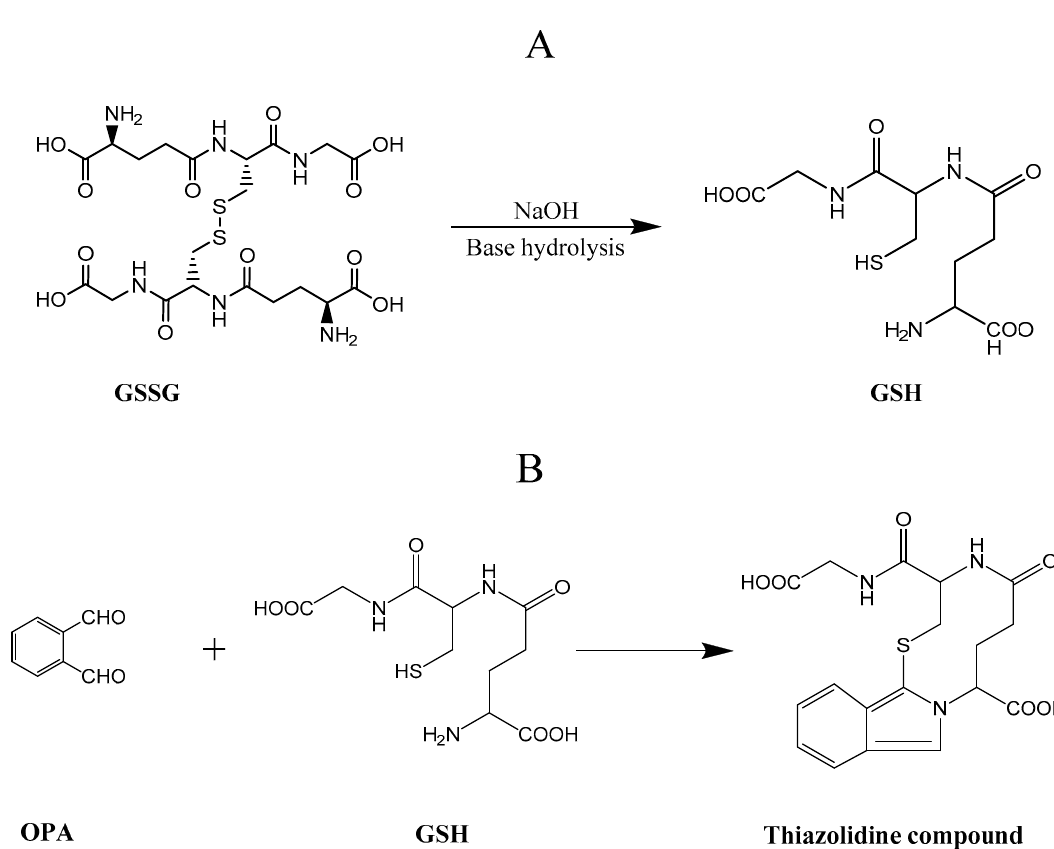
Figure 12. with O-pthaldialdehyde (OPA) glutathione reaction. ( A ) Oxidised glutathione (GSSG) is hydrolysed under condition of 0.1 M Sodium hydroxide (NaOH) to give reduced glutathione (GSH) ( B ) hetero-bifunctional OPA reaction with GSH. Table 2. Chromatography